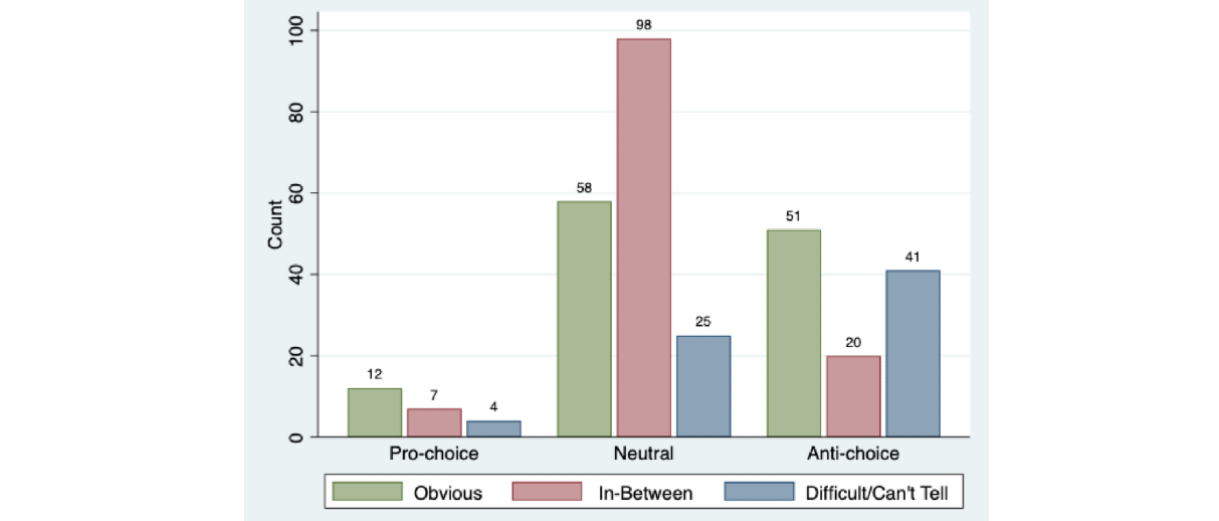
Figure 4. Counts of online abortion resources by slant and slant clarity